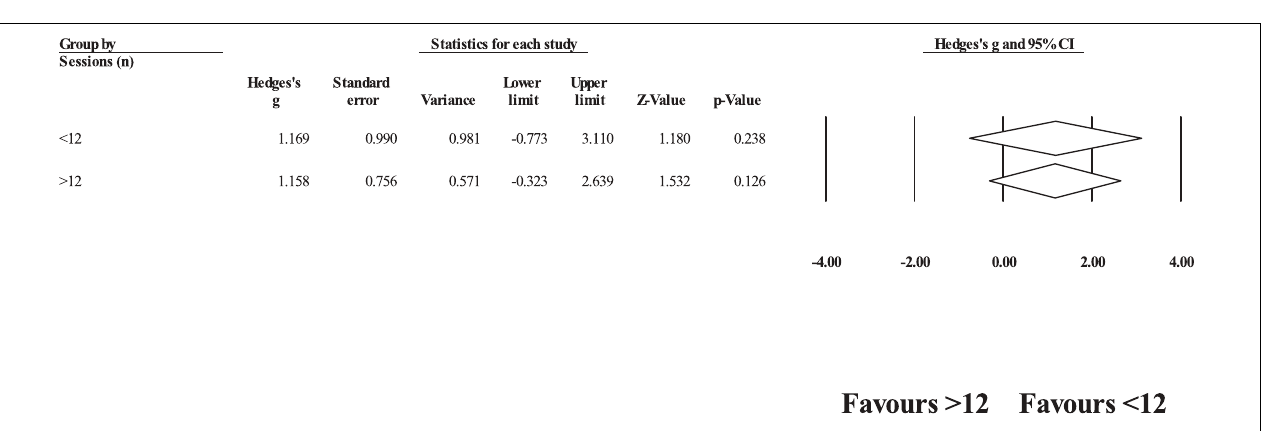
FIGURE 3 | Sub-group analyses testing the effects of programs that were longer and shorter than 12